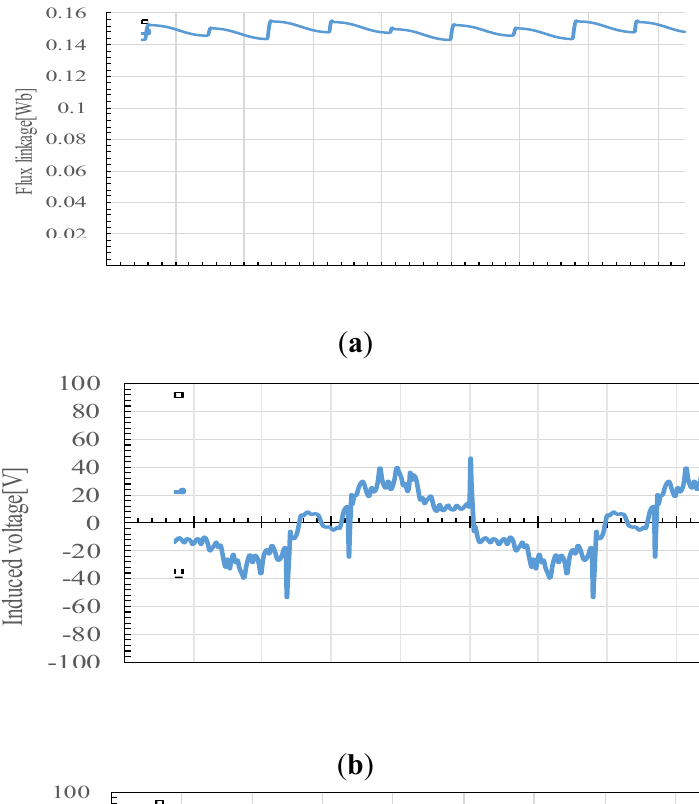
Figure 10. No-load induced voltage under half-wave rectified excitation with sinusoidal wave modulation. ( a ) Flux linkage; ( b ) induced voltage; ( c ) induced voltage for skewed rotor.